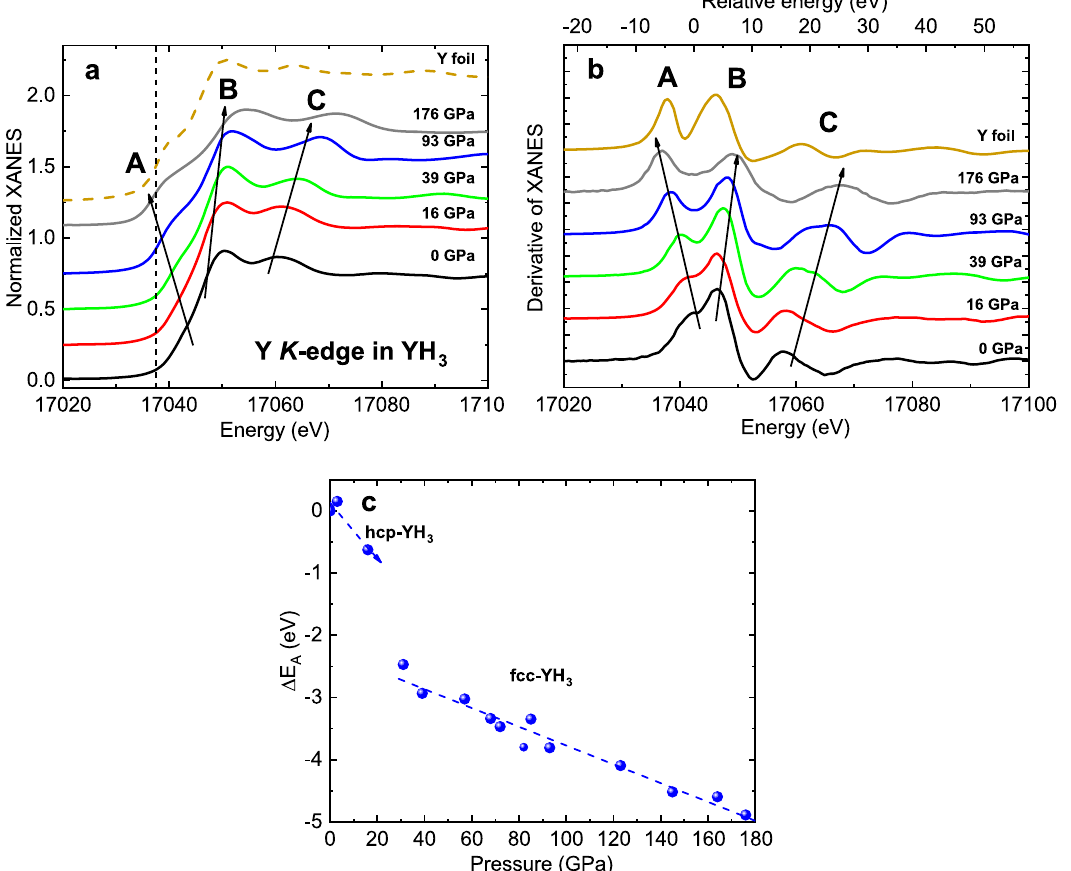
Fig. 3 Pressure-dependent XANES spectra of YH 3 . a Pressure-dependent Y K -edge XANES spectra of YH 3 . The XANES of yttrium foil at normal pressure (dashed line) is shown for comparison, and the position of its edge is indicated by the vertical dashed line. b The fi rst derivative of the normalized XANES spectra shown in a ; c Pressure dependence of the Y K -edge shift Δ E A relative to its position in the hcp